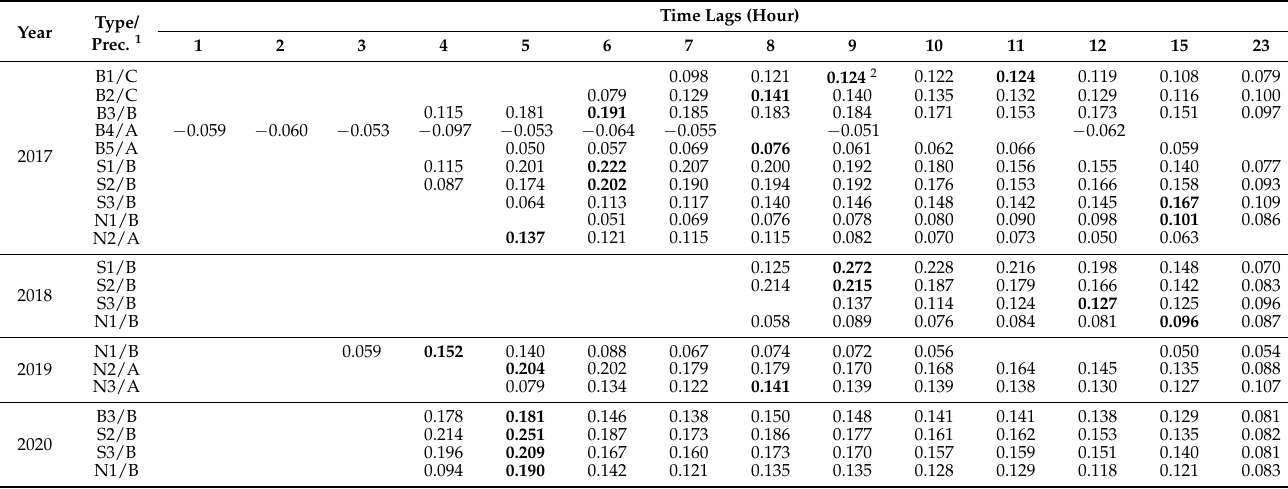
Table 1. Significant ( p < 0.05) cross-correlation coefficients at a selection of lags (in hours) between prewhitened time series of water table depth and precipitation events at each site in the years 2017, 2018, 2019, and 2020. Year Type/ Prec. 1